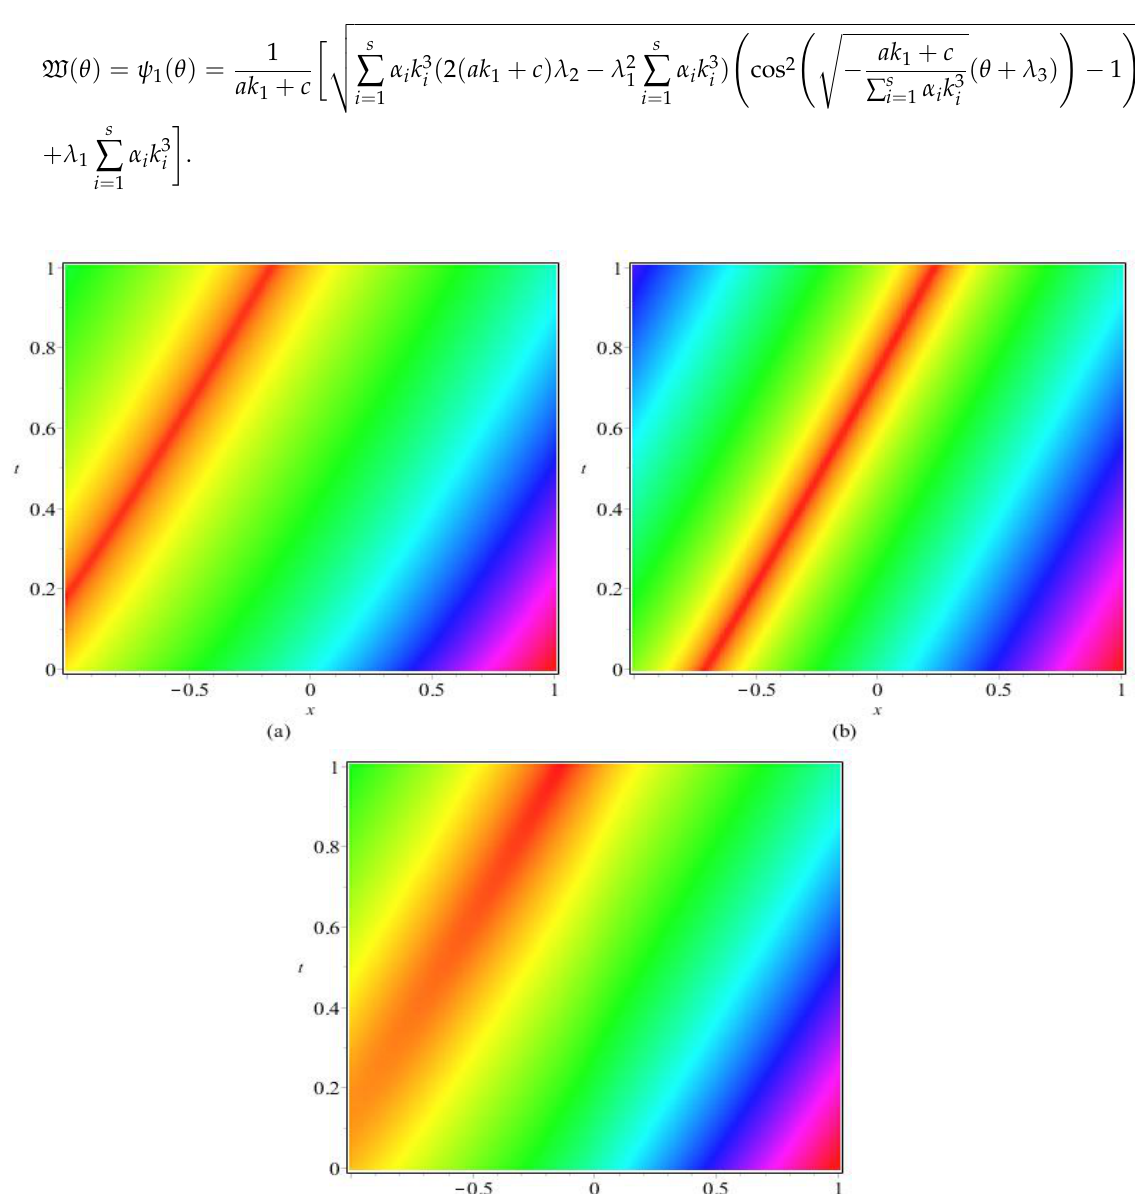
√ 3 2, m = 3, and β = α = 0.9 2